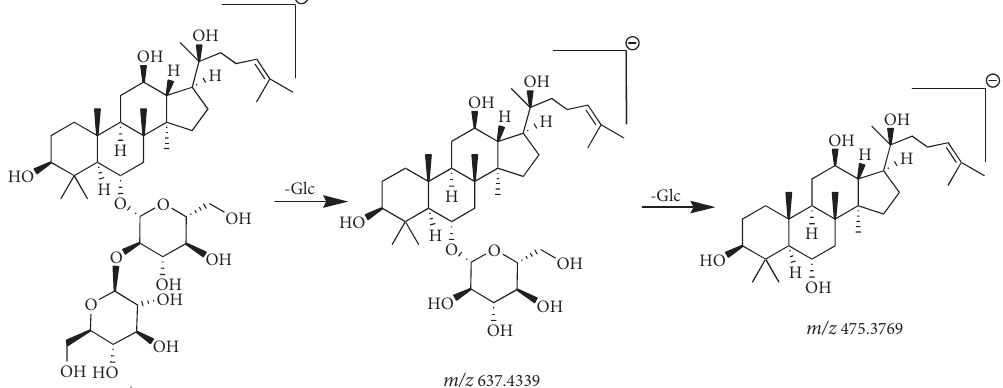
Figure 9: The fragmentation pathway of ginsenoside